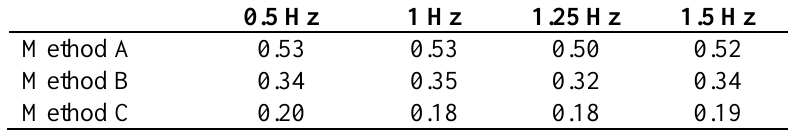
Table 6. RMSE between the pressure altitude and the reference vertical position, expressed in meters, for different values of motion frequency ( forced circular motion experiment).